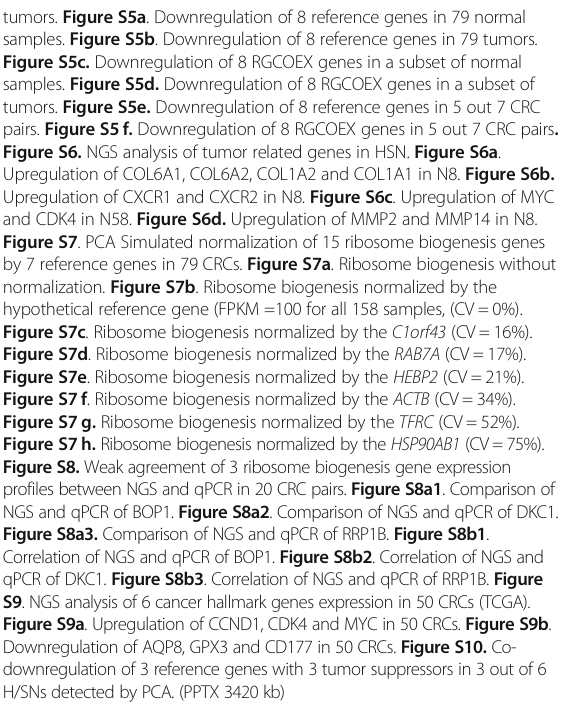
genes through correlation analysis. Table S10. Identification of 8 RGCOEX genes based on their correlation with 5 novel reference genes. Table S11. Genes coexpressed with 6 reference genes. Table S12. Expression profiles of 8 RGCOEX genes. Table S13. Expression profiles of Table S15. Oncogenes and tumor suppressors coexpressed with 3 reference genes (RAB1B, ACTR2 and CLTC). Figure S1. NGS analysis of 15 genes pertaining to ribosome biogenesis in 79 CRCs. Figure S1a. Upregulation of 15 genes pertaining to ribosome biogenesis in 79 CRCs . These 15ribosome biogenesis related genes were identified from 1223 upregulated genes (average T/ N >2 fold, FDR < 0.05 (ANOVA)) by DAVID